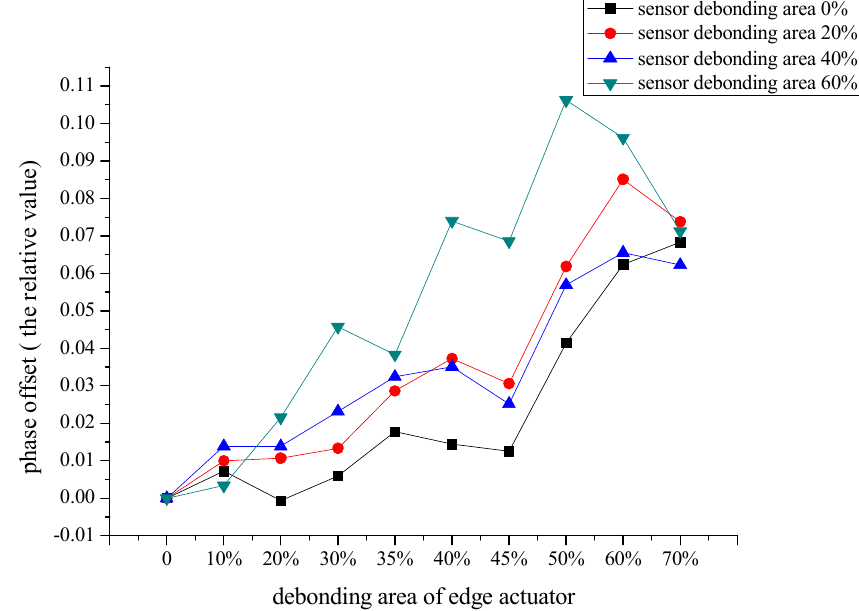
Figure 16. When the debonding area of the central sensor is 20%, 40% or 60%, the change of signal phase difference with the increase of the debonding area of the peripheral actuator, the excitation frequency is 50 kHz.